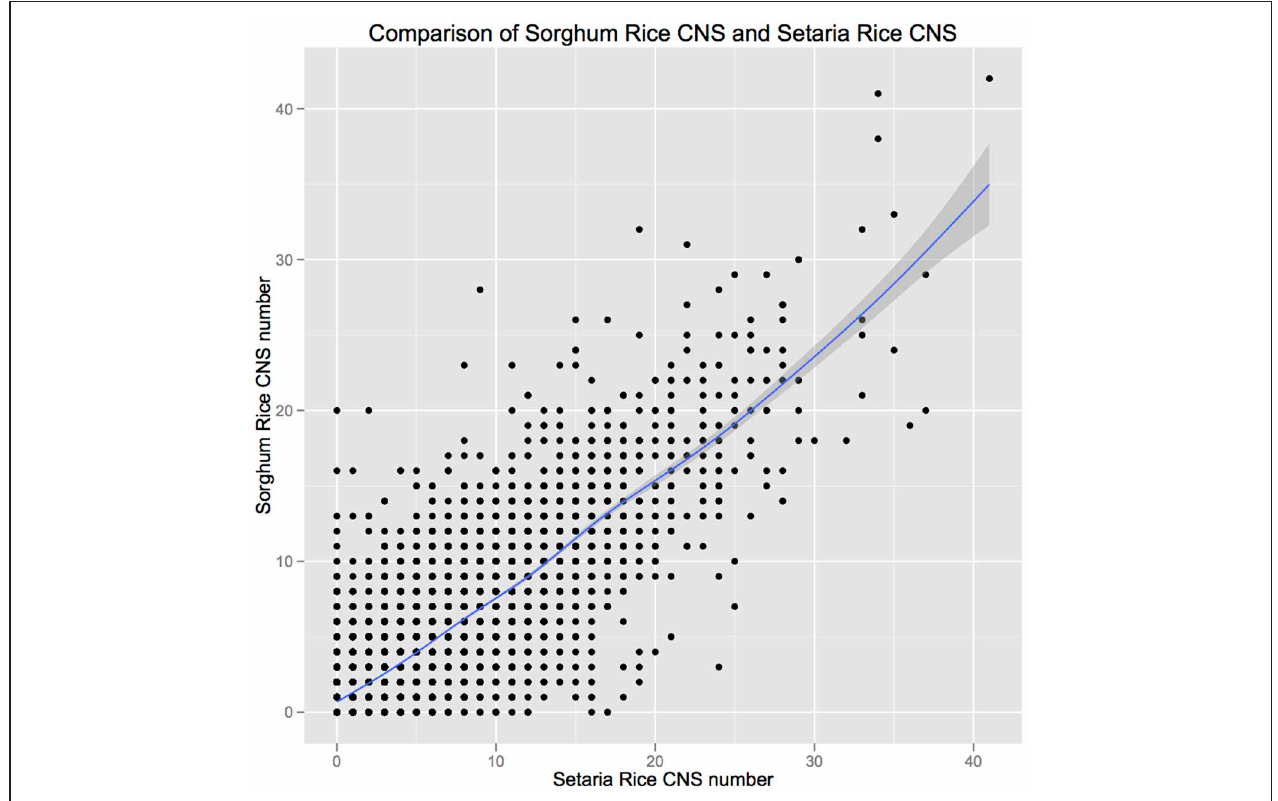
FIGURE A1 | Comparison of the number of discrete conserved noncoding sequences discovered for orthologous sorghum and setaria genes when compared to their common ortholog in rice.